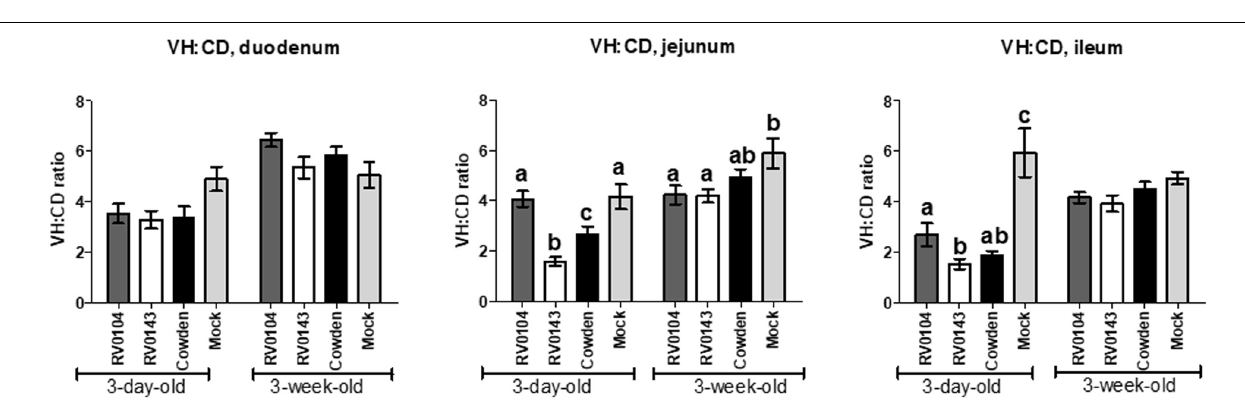
FIGURE 4 | Mean ( ± SEM) ratios of villi height and crypts depth of duodenum, jejunum and ileum sections of PRVC inoculated gnotobiotic piglets (3-days-old and 3-week-old) at PID 3. The tissue sections were preserved in 10% buffered formalin before histopathology. The ratio of villi height and crypt depths was used to determine the villous atrophy was follows; normal ( > 4.0:1), mild atrophy (3.1–4.0:1), moderate atrophy (2.1–3.0:1), and marked atrophy (1.1–2.0:1). Different letters (a,b,c) represent statistical significance within the